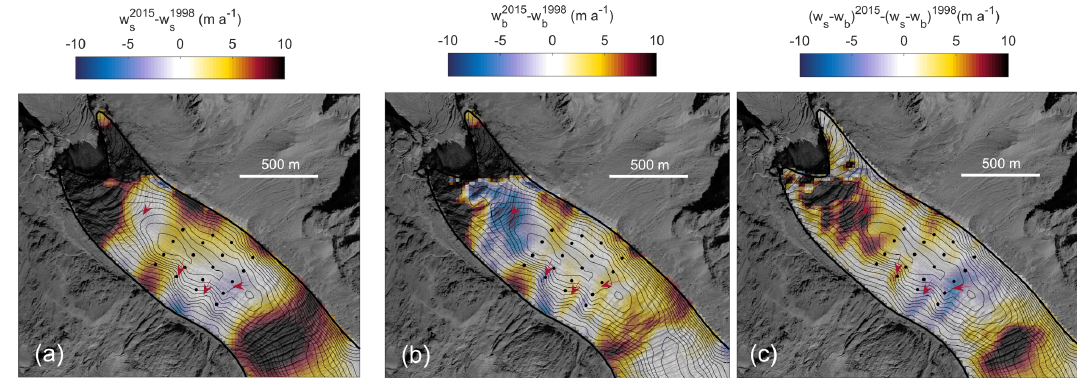
Figure 15. Modelled changes in vertical velocities at the surface (a) and at the bedrock (b) between 1998 and 2015. The righthand figure (c) shows the change in vertical velocity at the surface due to changes in flow convergence/divergence. The red arrows indicate the locations where changes in basal vertical velocities are compensated for by flow convergence/divergence changes, resulting in constant surface vertical